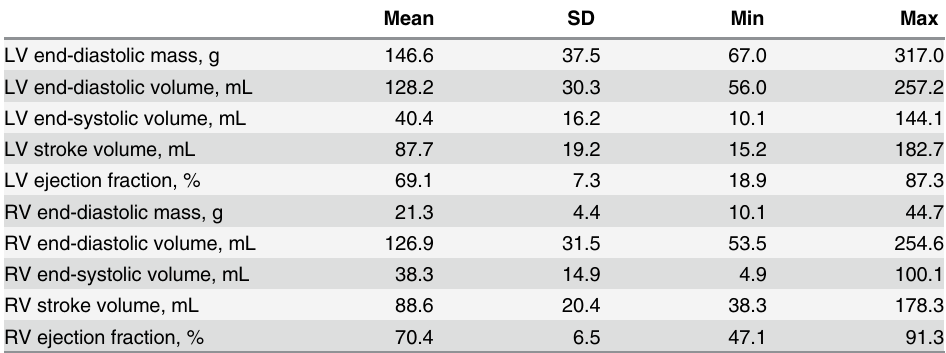
Table 2. Left and right ventricle measures. LV = left ventricle, RV = right ventricle, SD = standard